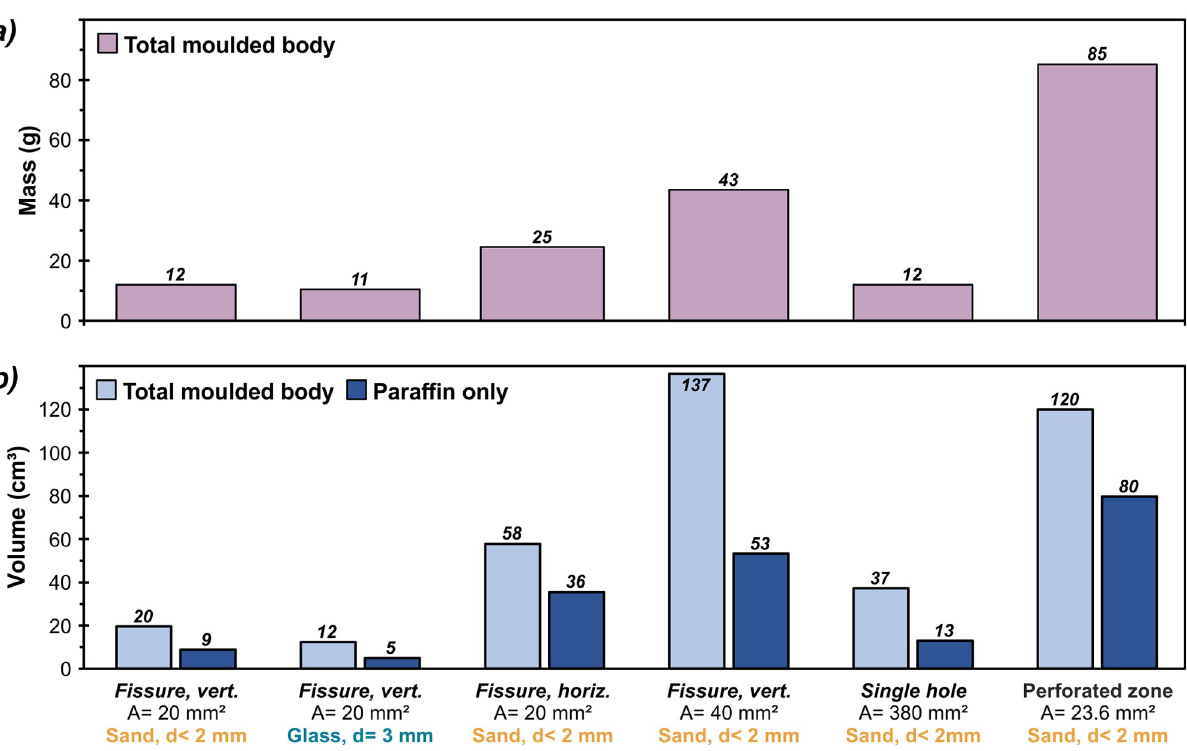
Fig 10. Masses (a) and volumes (b) of formed bodies consisting of paraffin wax and surrounding material, after induced leakage. vert: vertical fissure, horiz: horizontal fissure, A: total surface area of passageways as size of the leakage, d: grainsize of the surrounding